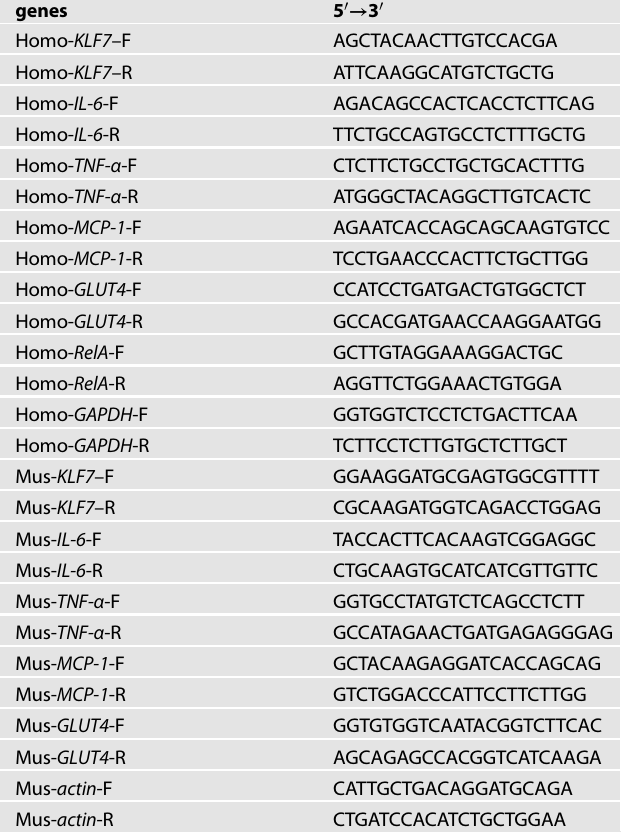
Table 1. Primes sequences used in this